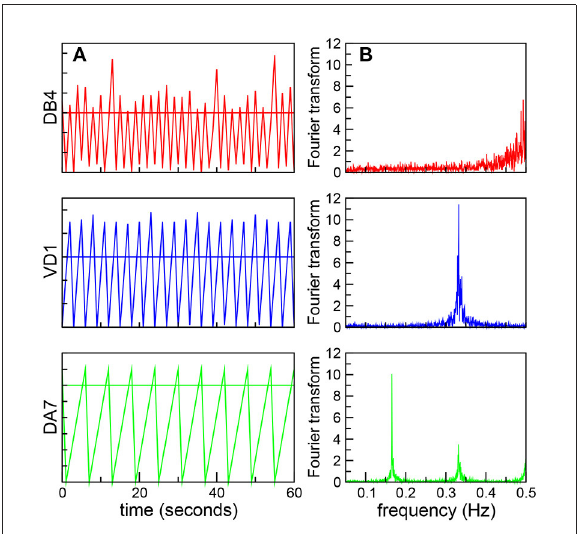
FIGURE1 Neurons oscillate at different frequencies. (A) Dynamics of three ventral cord motor neurons, DB4 (top, red), VD1 (middle, blue), and DA7 (bottom, green). The figure shows the neural signals as a function of time in the same 60 s time interval. The horizontal lines shows the threshold value h = 30 (B) Corresponding Fourier transforms with sharp peaks, used to define the characteristic frequency (cid:127)